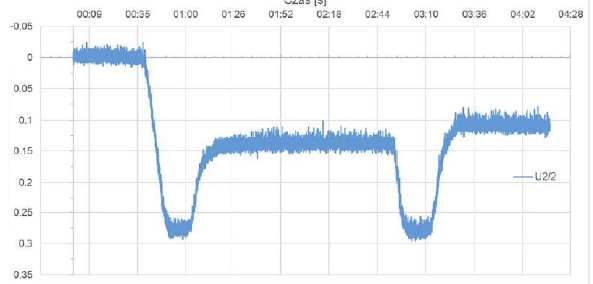
Fig 12 Figure 12: Change in vertical displacement of the shell point x during the travel of